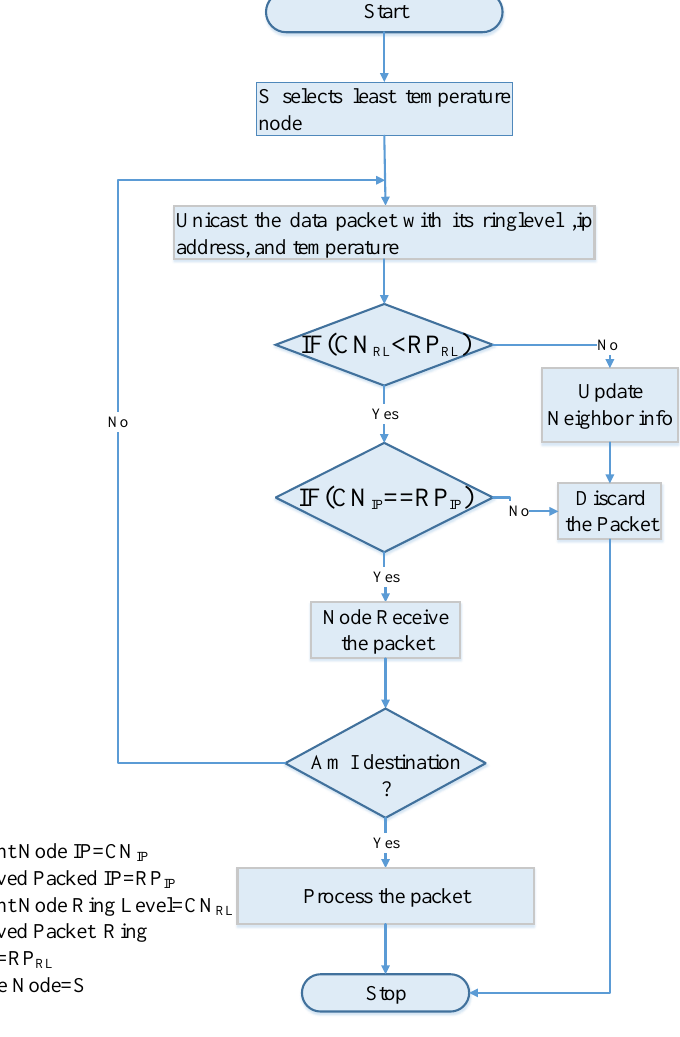
Figure 13. Flow chart of data transmission